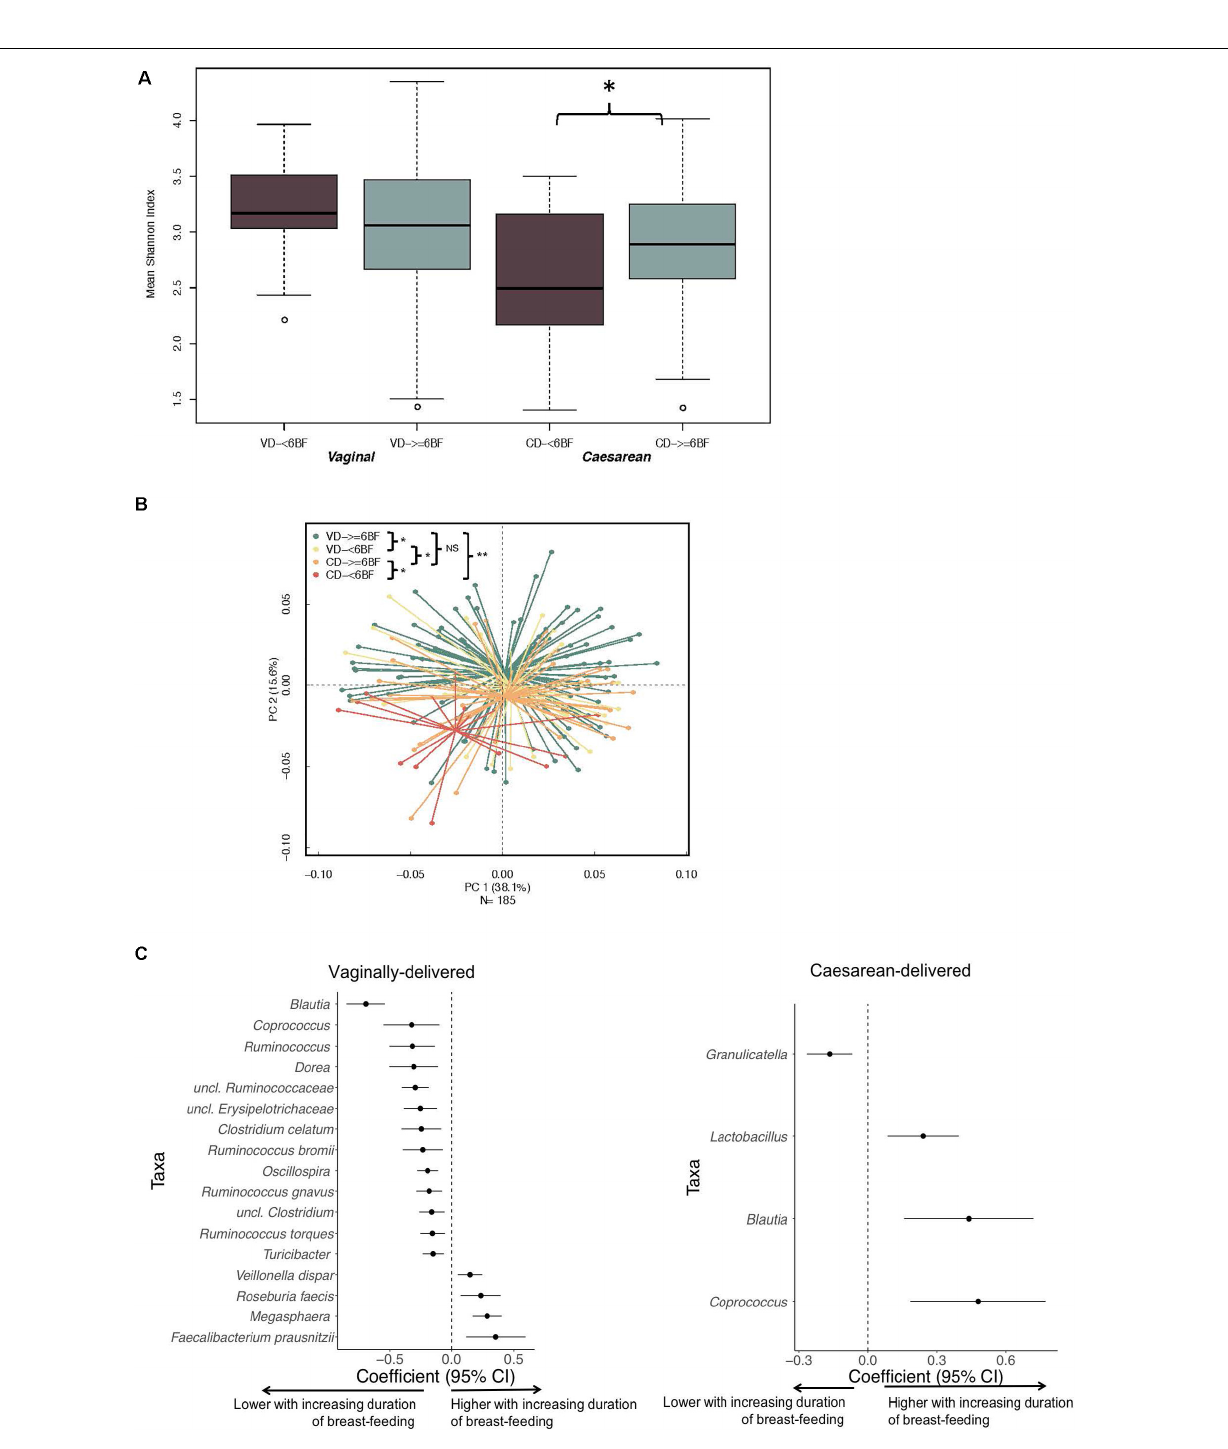
FIGURE 2 | The impact of breastfeeding duration on the developing microbiota over 1 year (characterized by 16S rRNA gene) differs by delivery mode. (A) Breastfeeding duration was significantly associated with 1-year alpha diversity indices for CD infants and not for VD infants. (B) Beta diversity of gut community profiles differed by feeding mode at 6 weeks and breast-feeding duration at 1 year as visualized with PCoA plots. Adjusted p -values are the result of the adonis2 model, adjusting for gestational age, early feeding mode and solid food introduction at the time of sample collection. (C) Differentially abundant taxa highlighting ASVs (at the genus level) significantly impacted by duration of breastfeeding for VD and CD infants adjusted for gestational age, early feeding mode and solid food introduction at the time of sample collection. Data was derived from utilizing all time-varying samples within a mixed effect model in MaAsLin. VD, vaginally delivered; CD, cesarean-delivered; VD- ≥ 6BF, vaginally delivered who breast-fed for > 6 months; VD- < 6BF, vaginally delivered who never breast-fed or breast-fed for < 6 months; CD- ≥ 6BF, caesarean-delivered who breast-fed for ≥ 6 months; CD- ≥ 6BF, operatively delivered who never breast-fed or breast-fed for < 6 months. * p < 0.05, ** p < 0.01, NS not